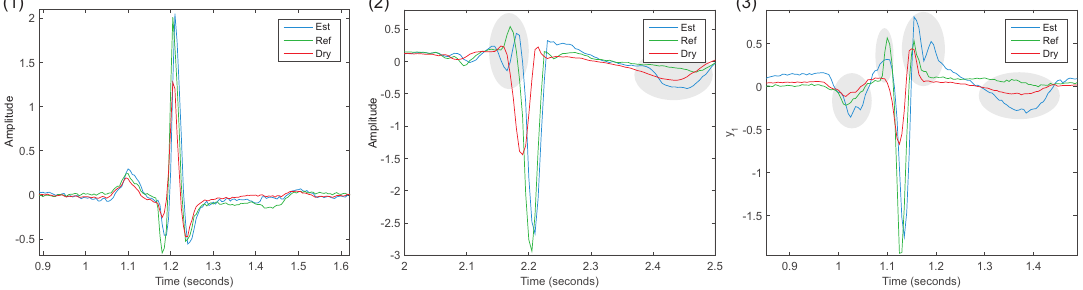
Figure 6. Estimation quality for different subjects ( 1 ) (aVF subject 1, FIR); ( 2 ) (aVR, subject 2, FIR); and ( 3 ) (aVF subject 1, SSM). Deformations are highlighted.